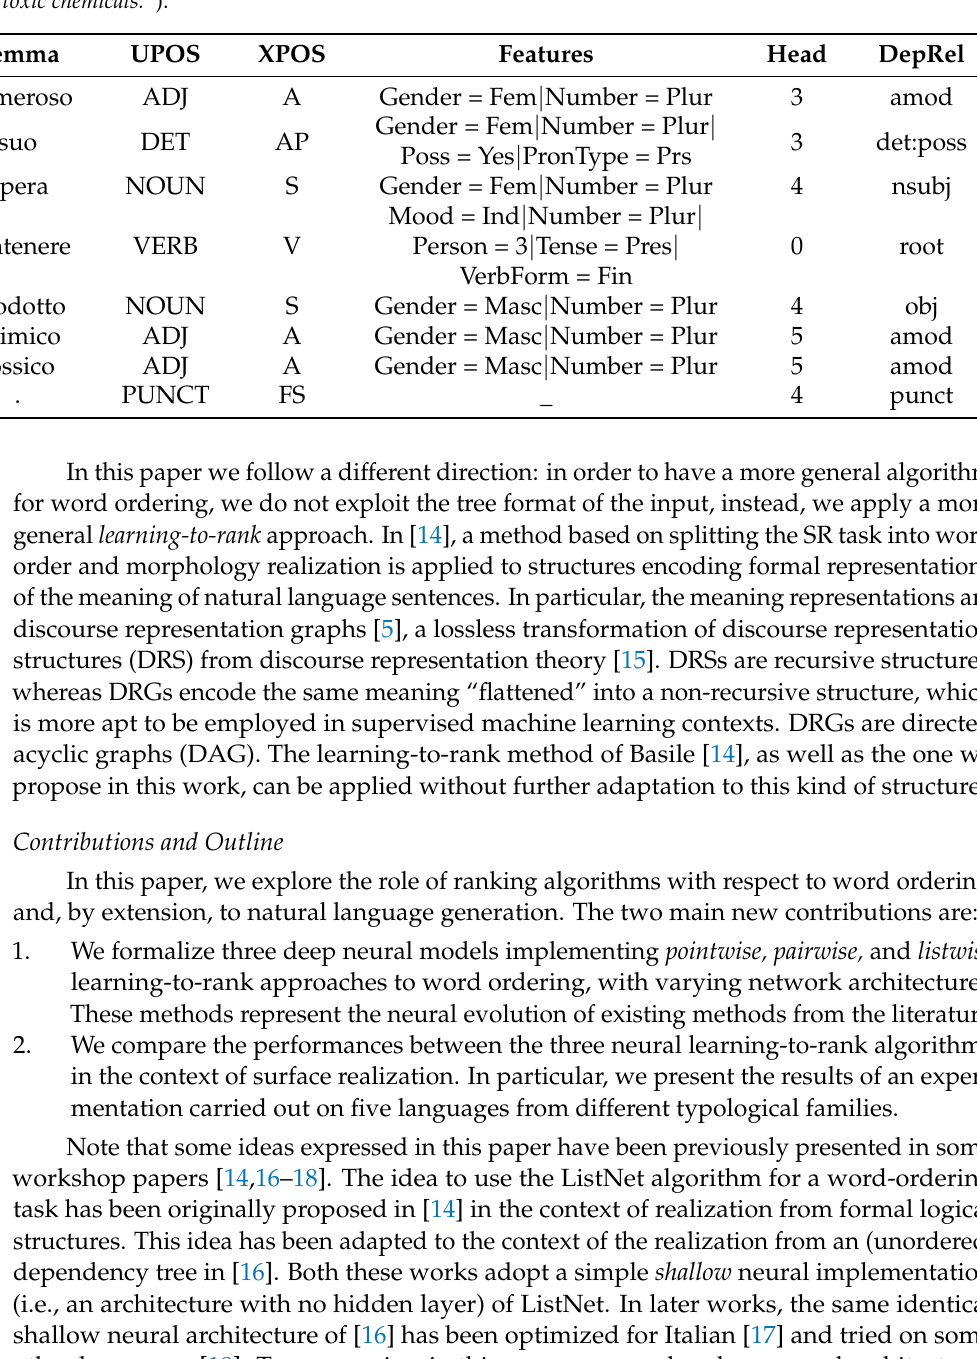
Table 1. Universal dependency tree for the Italian sentence “Numerose sue opere contengono prodotti chimici tossici.” ( “Many of his works contain toxic chemicals.”